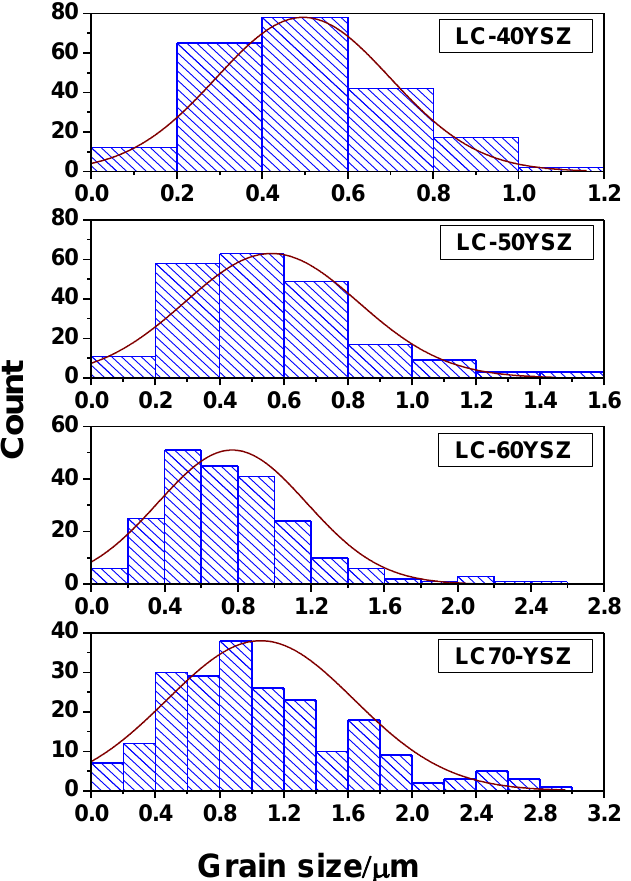
Figure 5. Grain-size distribution of hot-pressed LC-YSZ composites . The random occurrence of pores can be explained by the presence of agglomerates that may have formed during the homogenization and drying of mixed powders.